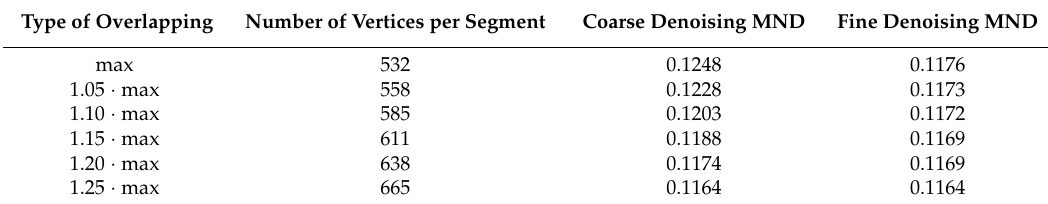
Table 3. Mean normal difference using different size of equal-sized overlapped submeshes (Julio Model with 36,201 vertices 70 segments).